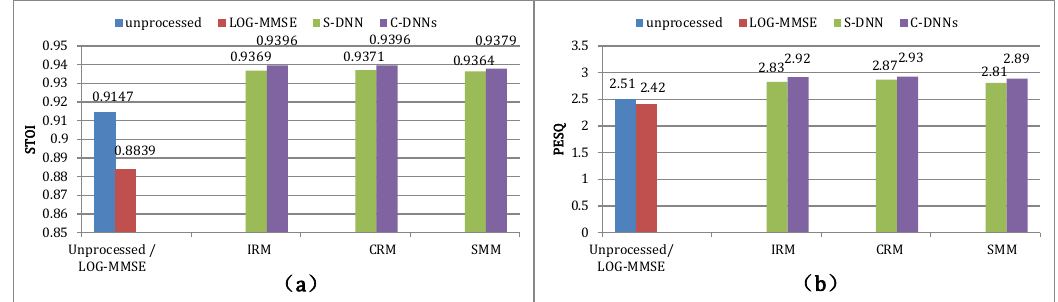
Figure 6. Comparison of the existing and the proposed methods. LOG-MMSE is reproduced based on [7], S-DNN (IRM) and S-DNN (CRM) corresponding to [20,26], respectively. For C-DNNs, the results obtained using three training targets IRM, SMM, and CRM are provided for comparison. ( a ) STOI metric. ( b ) PESQ metric.